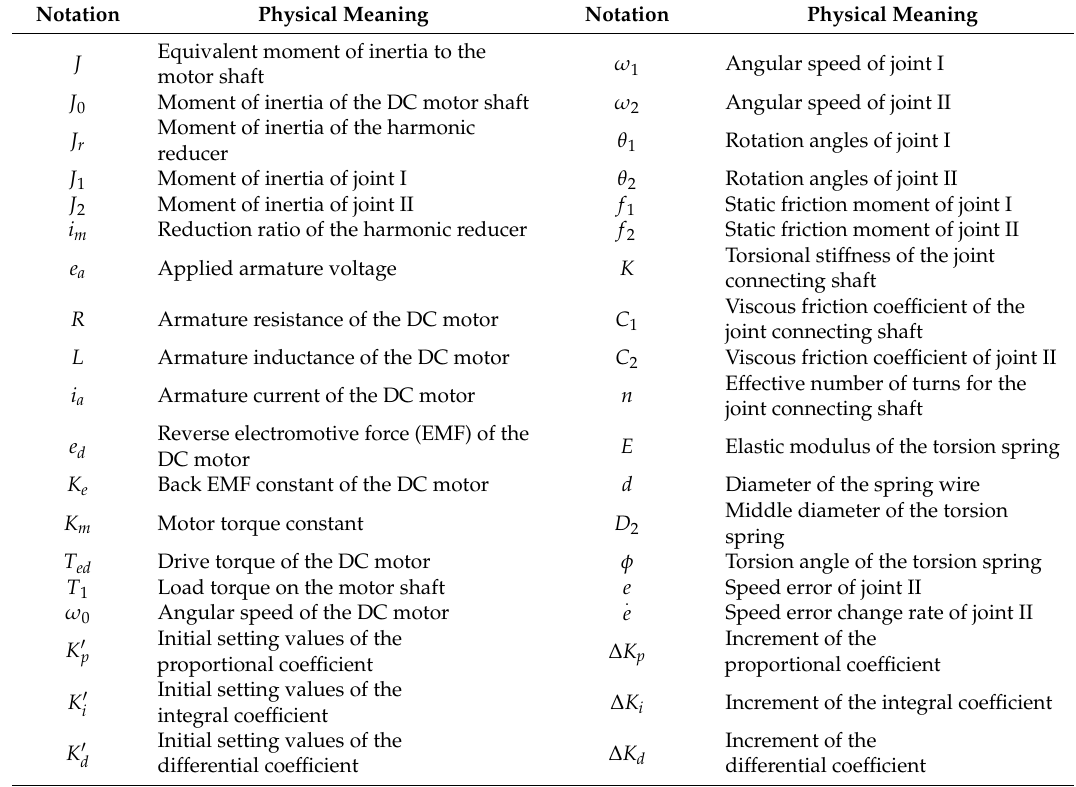
Table A1. Table of